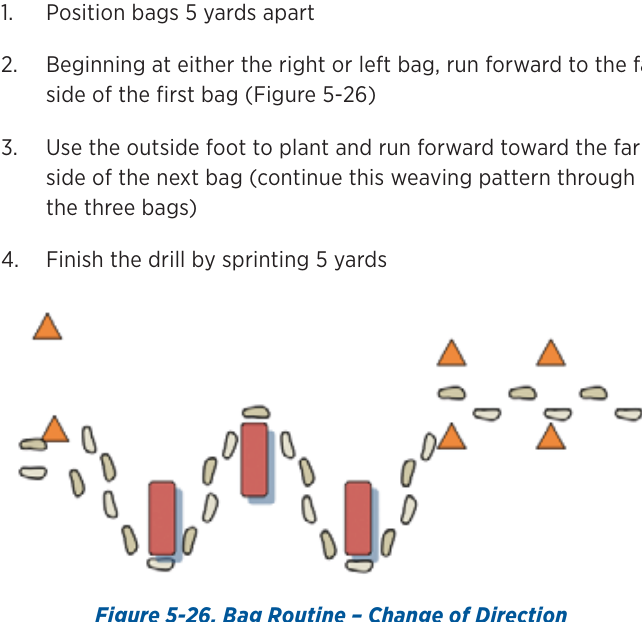
Figure 5-26. Bag Routine – Change of